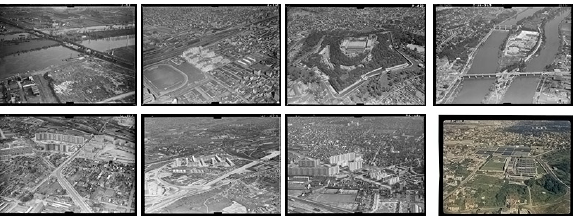
Figure 2. Some examples of IGN aerial oblique imagery: area of Nanterre, period 1947-1960 ( c (cid:13)